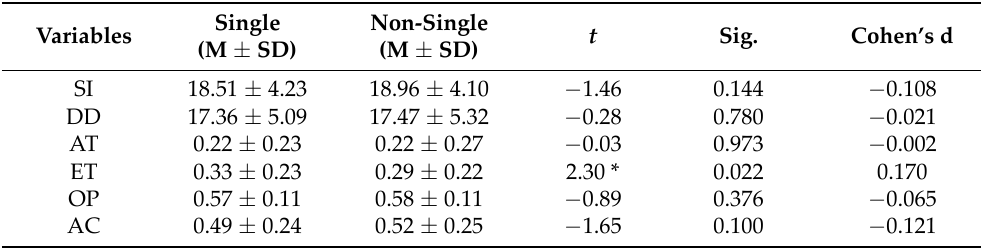
Table 6. Differences of intimate relationship in measured variables ( n = 734: single = 358, non‑ single =